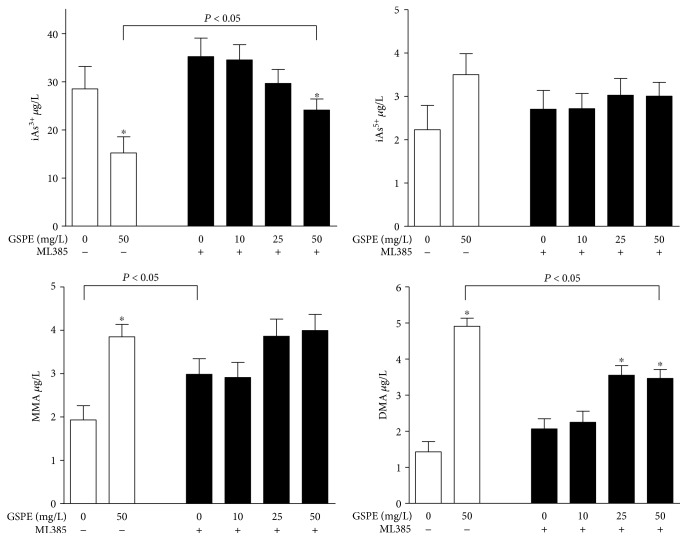
Effects of grape seed procyanidin extract on arsenic methylation in Nrf2-suppressed cells (mean ± SD, n = 3). Nrf2-suppressed cells were treated with arsenic (25 μM) and grape seed procyanidin extract (GSPE; 0, 10, 25, and 50 mg/L) for 24 h. ∗Versus the GSPE (0 mg/L) group, P < 0.05. Treatment with 50 mg/L GSPE caused a prominent increase in iAs3+ levels compared with the same intervention in Nrf2 normal cells. However, DMA content in the 50 mg/L GSPE group after Nrf2 inhibition was lower than that in Nrf2 normal cells treated with the same dose. In Nrf2-suppressed cells, GSPE had no significant effect on MMA compared with Nrf2 normal cells. In addition, MMA content in Nrf2-suppressed cells was higher than that in Nrf2 normal cells.